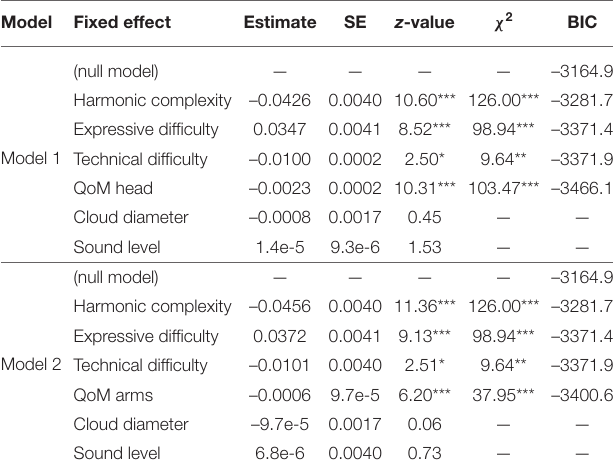
TABLE 5 | Results of linear mixed effects modelling for